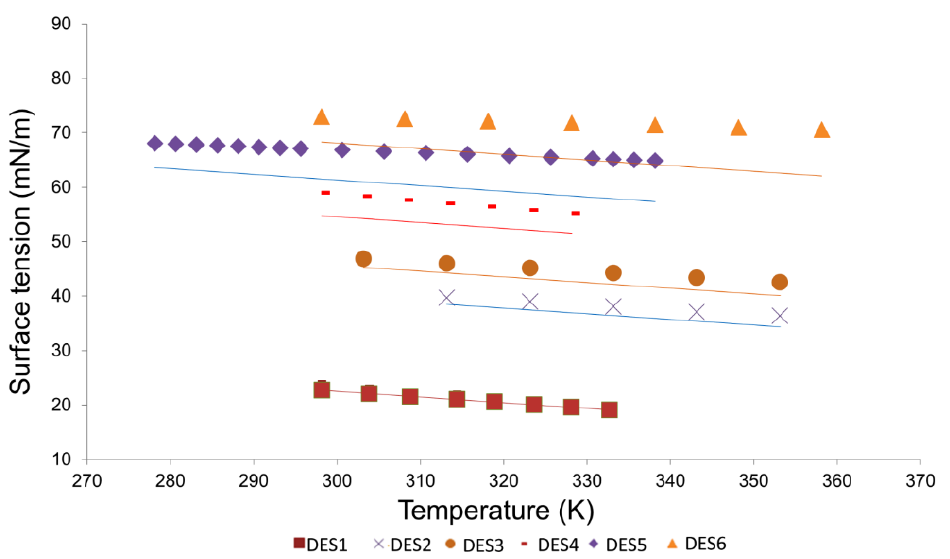
Figure 5. Comparison of surface tension calculated by the M12 model with literature data in the temperature range from 278.15-358.15 K for six DESs at atmospheric pressure. DES1: DL-menthol and octanoic acid (3:1); DES2: tetrabutylammonium chloride and arginine (8:1); DES3: tetraprpylammonium bromide and ethylene glycol (1:6); DES3: tetraprpylammonium bromide and ethylene glycol (1:6); DES4: N,N-diethylethanolammonium chloride and glycerol (1:5); DES5: choline chloride and glycerol (1:5); DES6: choline chloride and D-glucose (1:1).